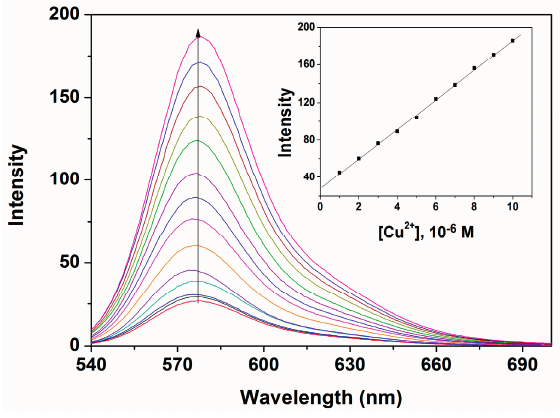
Figure 4. Fluorescence response of P (10 μ M) with various concentrations of Cu 2+ in ethanol-water solution (9:1, v:v. 20 mM HEPES, pH 7.0). Inset: the fluorescence of P (10 μ M) as a function of Cu 2+ concentrations (Em: 577 nm).